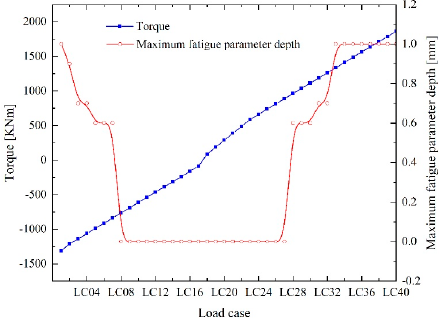
Figure 14. Variation of hazard source depth with load.